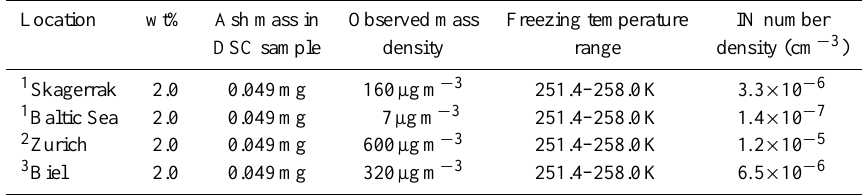
Table 2. The nucleation temperature range of the best IN in the Ey0 2wt% < 20µm bulk freezing experiments, and the corresponding estimated number density per air volume assuming a single best IN, when the mass of ash in the sample (and therefore the number of ash particles) is scaled to ash mass density observed in the atmosphere.